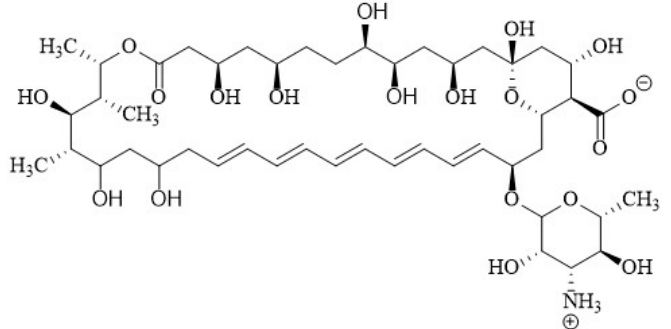
Figure 6. Chemical structure of oxidized amphotericin B form (AmB-ox, n = 5), where n is the number of double bonds in the hydrophobic chain.